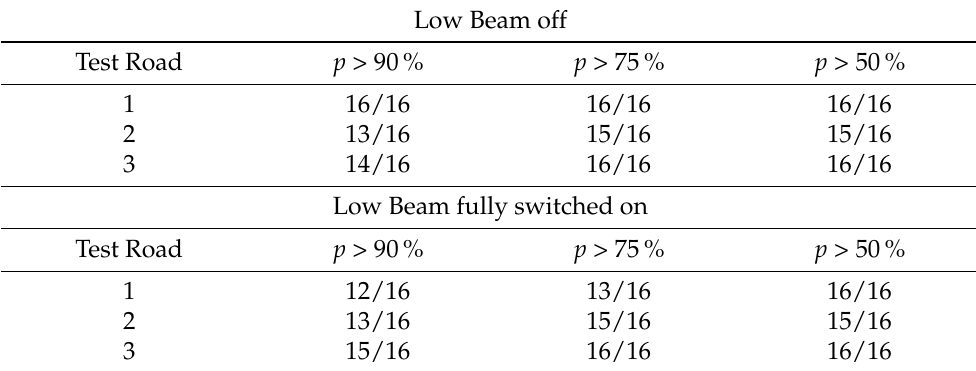
Table 9. Proportion of detected objects on vehicle position